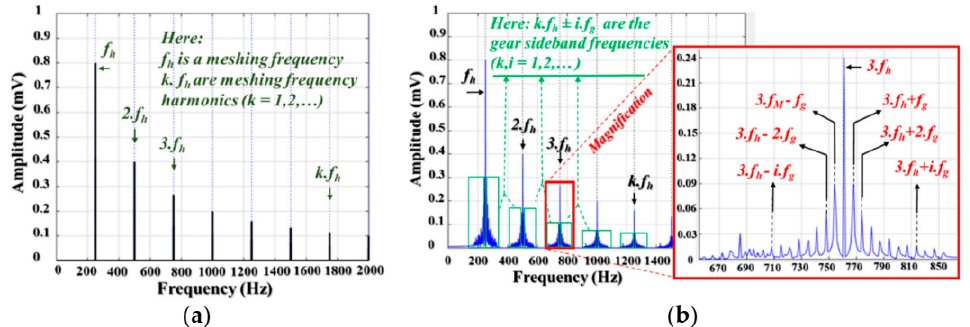
Figure 3. The example vibration signals present in the frequency domain: ( a ) a normal gearbox and ( b ) a defective